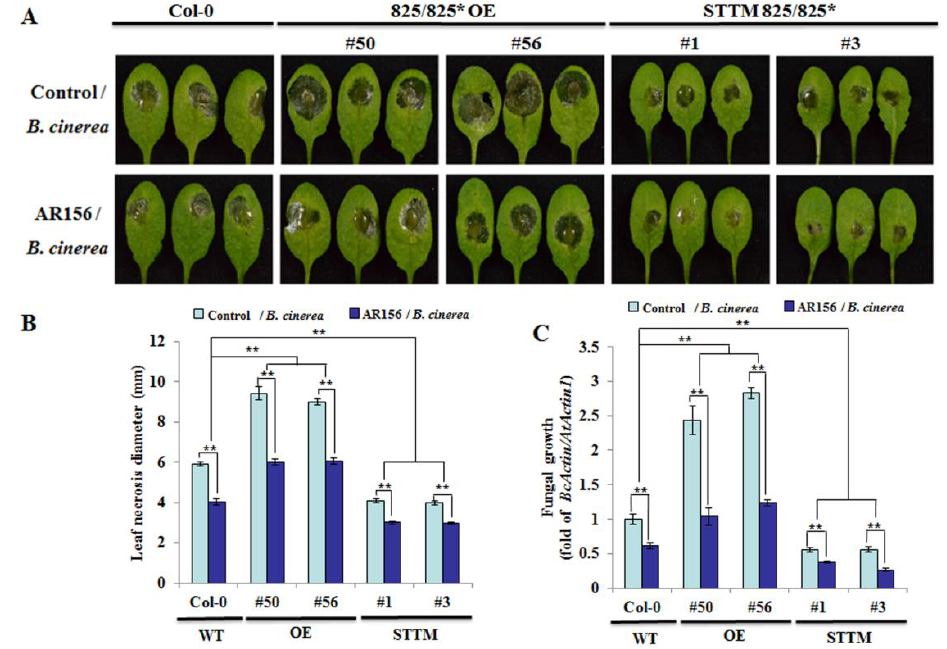
Figure 2. The levels of resistance to B. cinerea B1301 with di ff erent genotypes.Three-week-old Arabidopsis plants from Col-0, miR825 / 825* overexpressing (OE) lines (#50 and #56), and STTM825 / 825* lines (#1 and #3) were pretreated with AR156 at 5 × 10 8 CFU / mL or 0.85% NaCl (control) as a root drench; at 7 dpt, all plants were infected with B. cinerea B1301 by dropping 10 µ L of its spore suspension (1 × 10 6 spores / mL) on the midvein of each side of a leaf. ( A ) Disease symptoms on leaves of each tested plant line at 2 dpi. ( B ) Necrotic lesions were evaluated at 2 dpi by determining their average diameter on one leaf per plant, with a total of three plants evaluated for each sample. ( C ) In